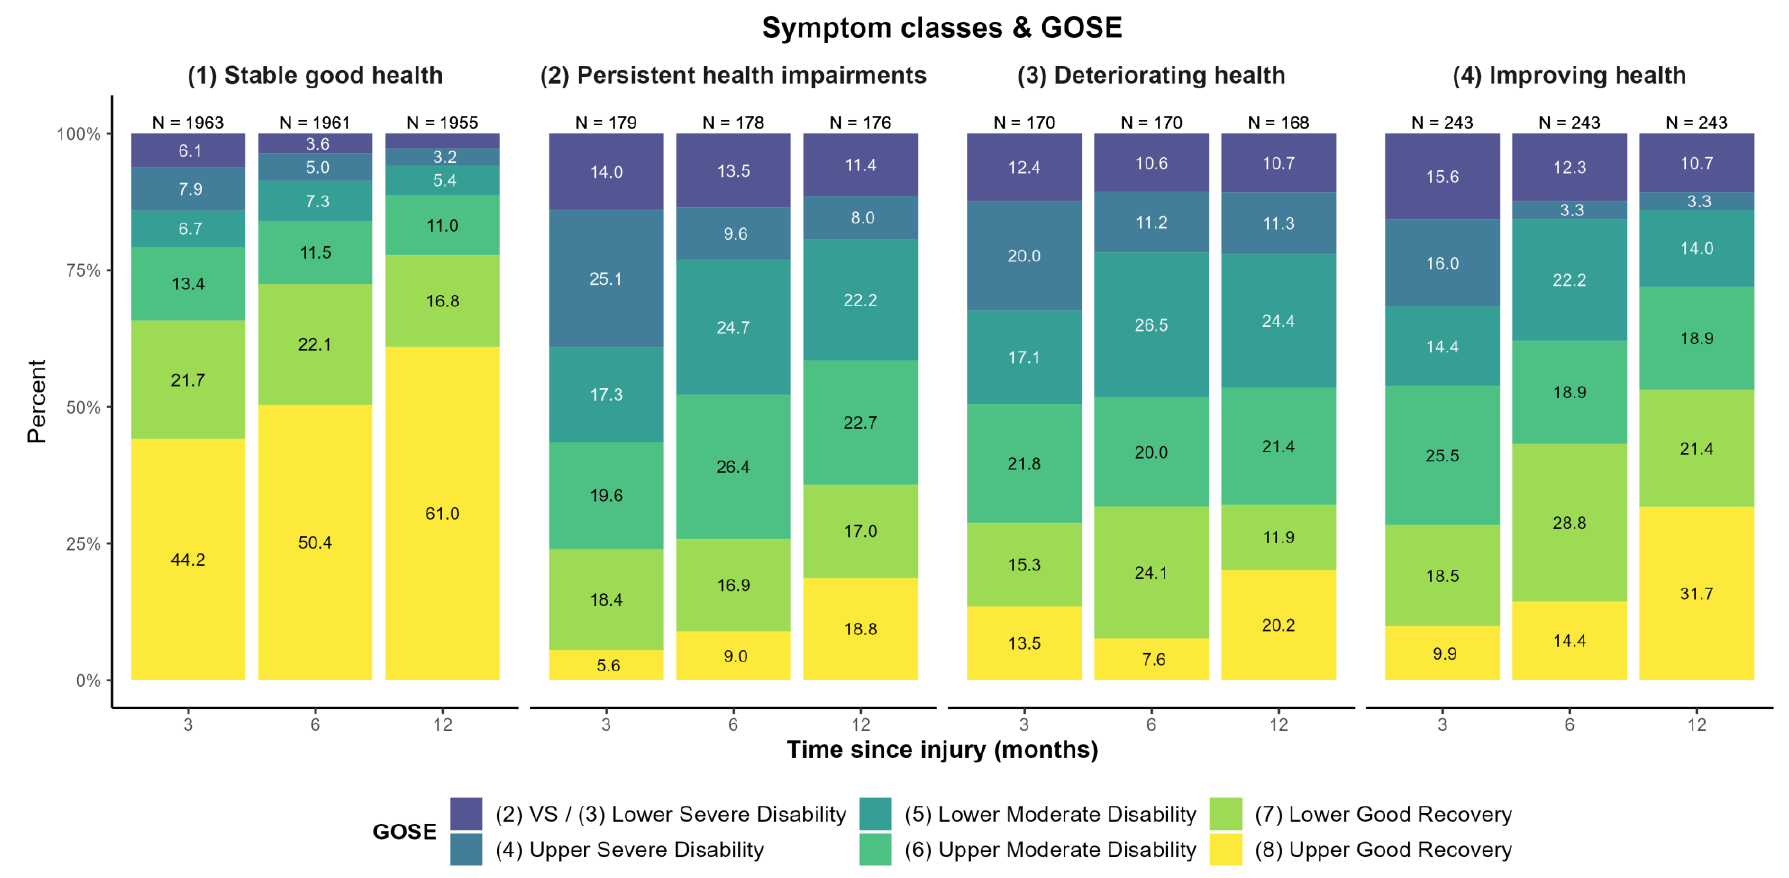
Figure 5. GOSE-levels at three, six, and twelve months after TBI for each symptom trajectory class. Decreasing sample sizes due to death of participants. Percentages < 3% not displayed.